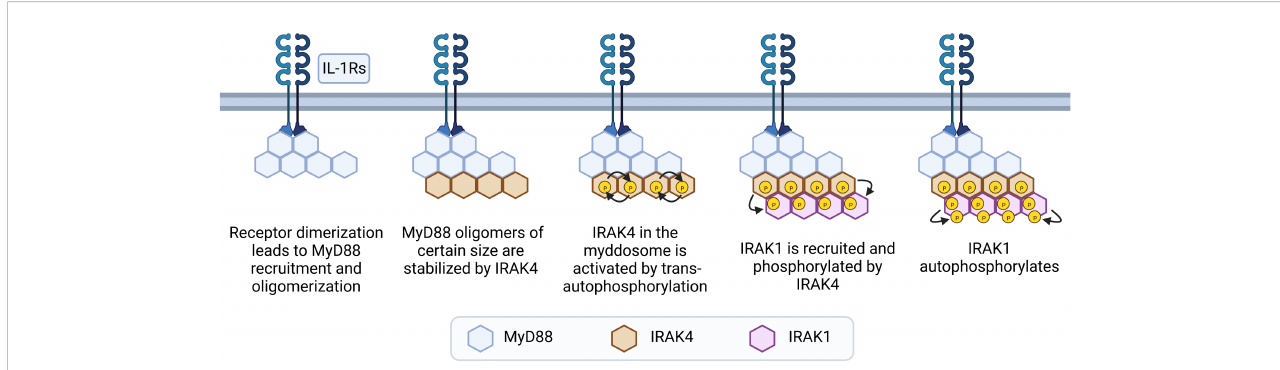
FIGURE 3 Steps of myddosome assembly. Dimerization of IL-1R or TLRs (except TLR3) leads to conformational changes in their cytoplasmic TIR domains, allowing TIR-TIR interactions with molecules of MyD88 to occur, either directly or via Mal dimers. This leads to formation of small and unstable MyD88 oligomers, which grow if receptor activation is sustained. After reaching a certain size threshold, MyD88 oligomers are stabilized by IRAK4. Interactions with MyD88 allows IRAK4 to trans-autophosphorylate and recruit IRAK1. Next, IRAK1 is activated by phosphorylation events mediated by IRAK4, and then further activated by auto-phosphorylation in its ProST regions, allowing signaling to occur.